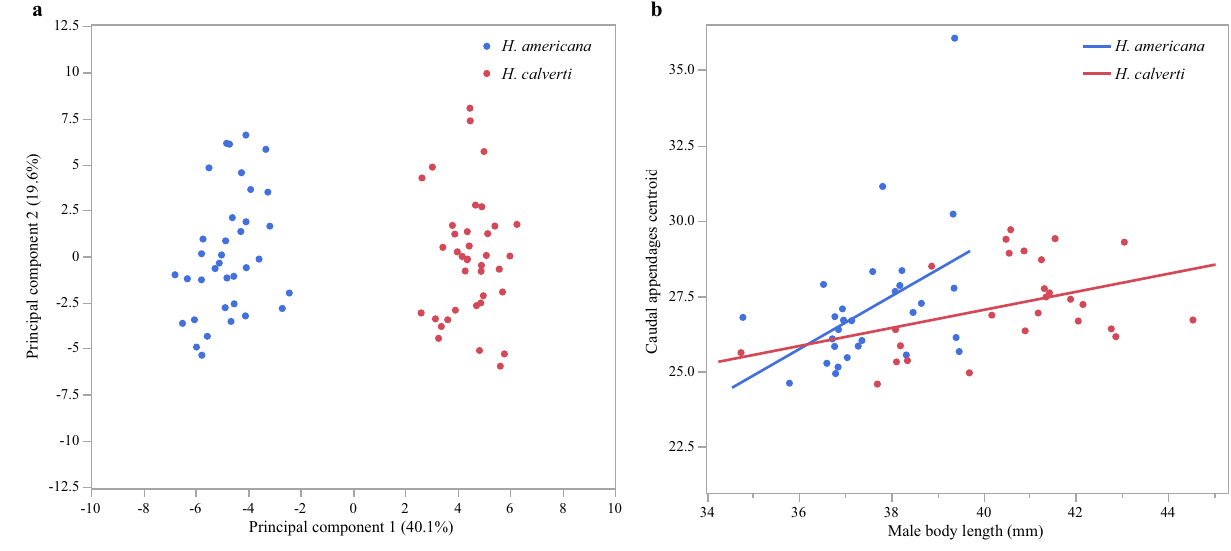
Figure 4. Differences in shape and size of caudal appendages. ( a ) Principal components analysis for the shape of superior caudal appendages of 77 males. ( b ) Relationship between the body length and the size of caudal appendages for each